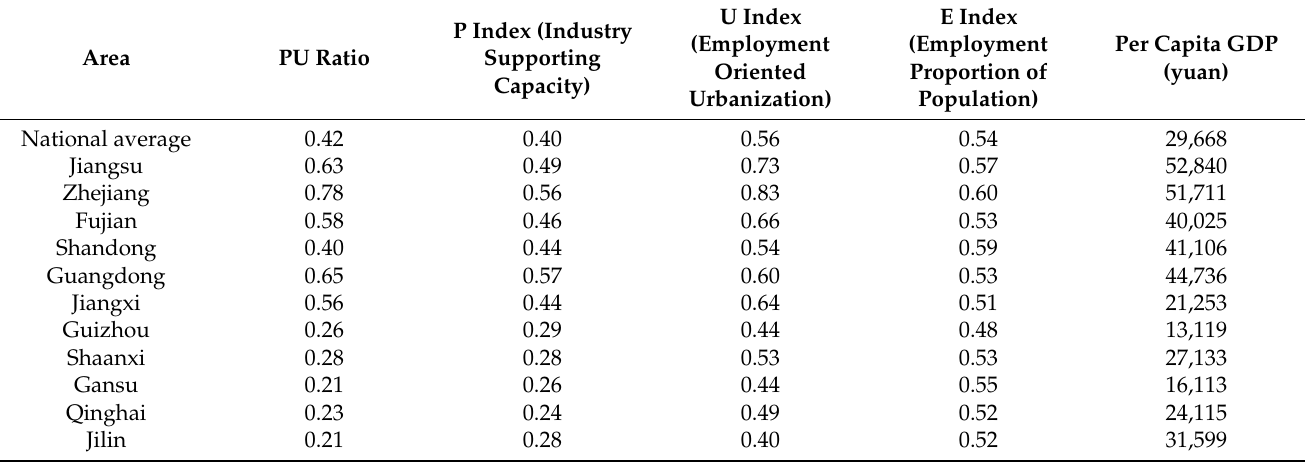
Table 2. The calculation results of PU ratio and related indexes in central provinces of China in 2010.